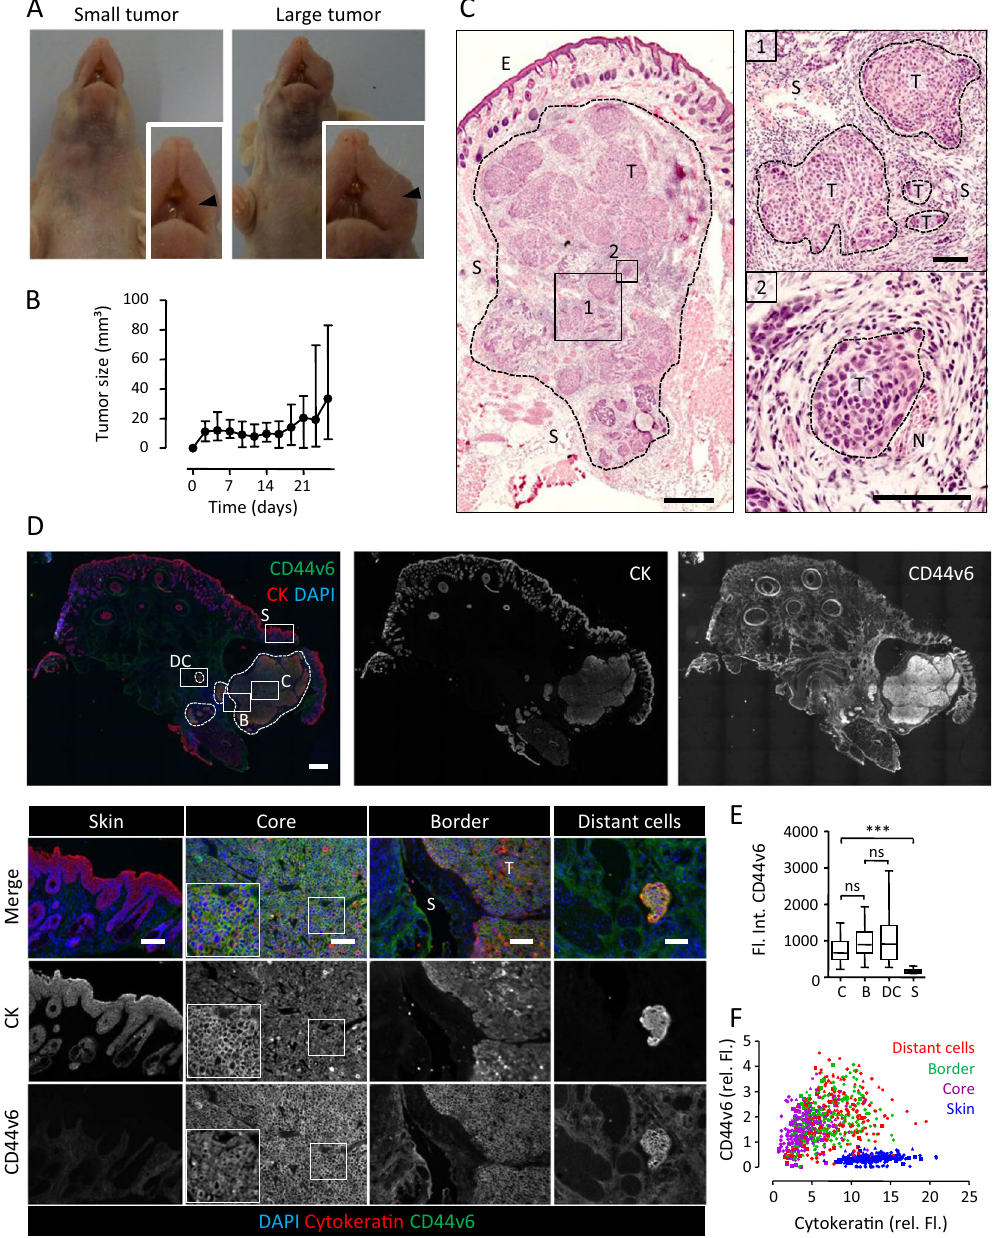
Figure 2. Invasive HNSCC mouse xenograft model for in vivo detection of CD44v6. ( A) Macroscopic detection of a representative small and large tumor in the left cheek of two different mice. Arrowhead indicates the tumor location. ( B ) Growth curve of UT-SCC58 tumors. Data show the means of 12 mice. ( C ) Central section of an UT-SCC58 tumor, showing multifocal invasive tumor islands in the interstitium (1) and in perineural location (2). Scale bars indicate 500 µ m (overviews) and 100 µ m (zooms). ( D ) Expression of CD44v6 and pan-cytokeratin (CK) in UT-SCC58 tumors. Dotted lines mark the tumor border and tumor islands. Scale bars indicate 500 µ m (overviews) and 100 µ m (zooms). ( E ) Whole-region analysis of (D). Staining intensity of CD44v6 in different areas analyzed at day 28 after implantation. Data show medians from 12–38 analyzed images per tumor from 4 independent tumors. ( F ) Single cell analysis of (D). Fluorescence intensities after background substraction for CD44v6 and CK of the same tumors as in (E). 50 cells were analyzed per subregion and geometric symbols represent 5 different tumors. Core of the tumor (C), border of the tumor (B), distant cells (DC), skin